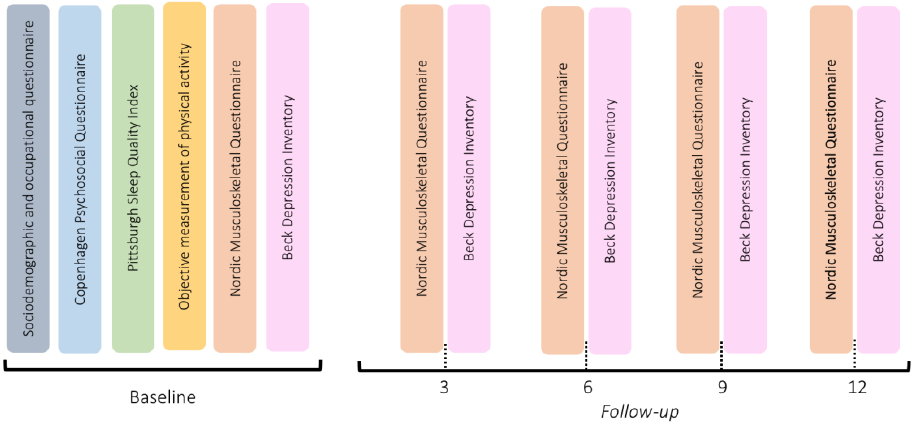
Figure 2 . Questionnaires applied to each stage of the